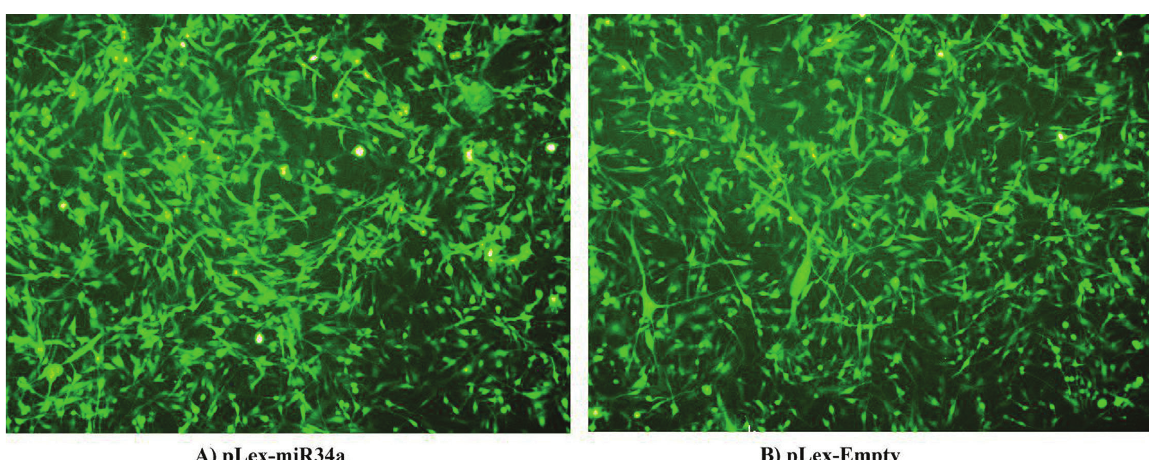
FIGURE 3 - Estimating the transduction efficacy of U251 cells after 48 h of transduced with (A) pLex-miR-34a lentivector or (B) pLex-Empty. The transduction efficacy estimated 90 %.